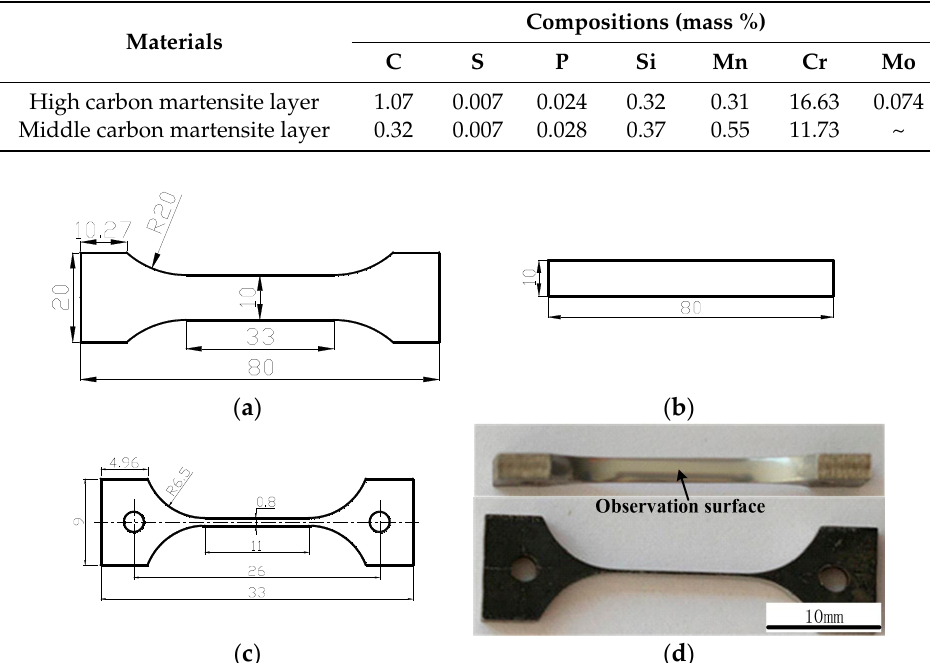
Figure 2. The size of the specimens involved in the experiment (dimensions in mm). ( a ) Dimensions of tensile specimens, ( b ) Dimensions of bending specimens, ( c ) Dimensions of in-situ tensile specimens, ( d ) macro figure of in-situ tensile specimens.